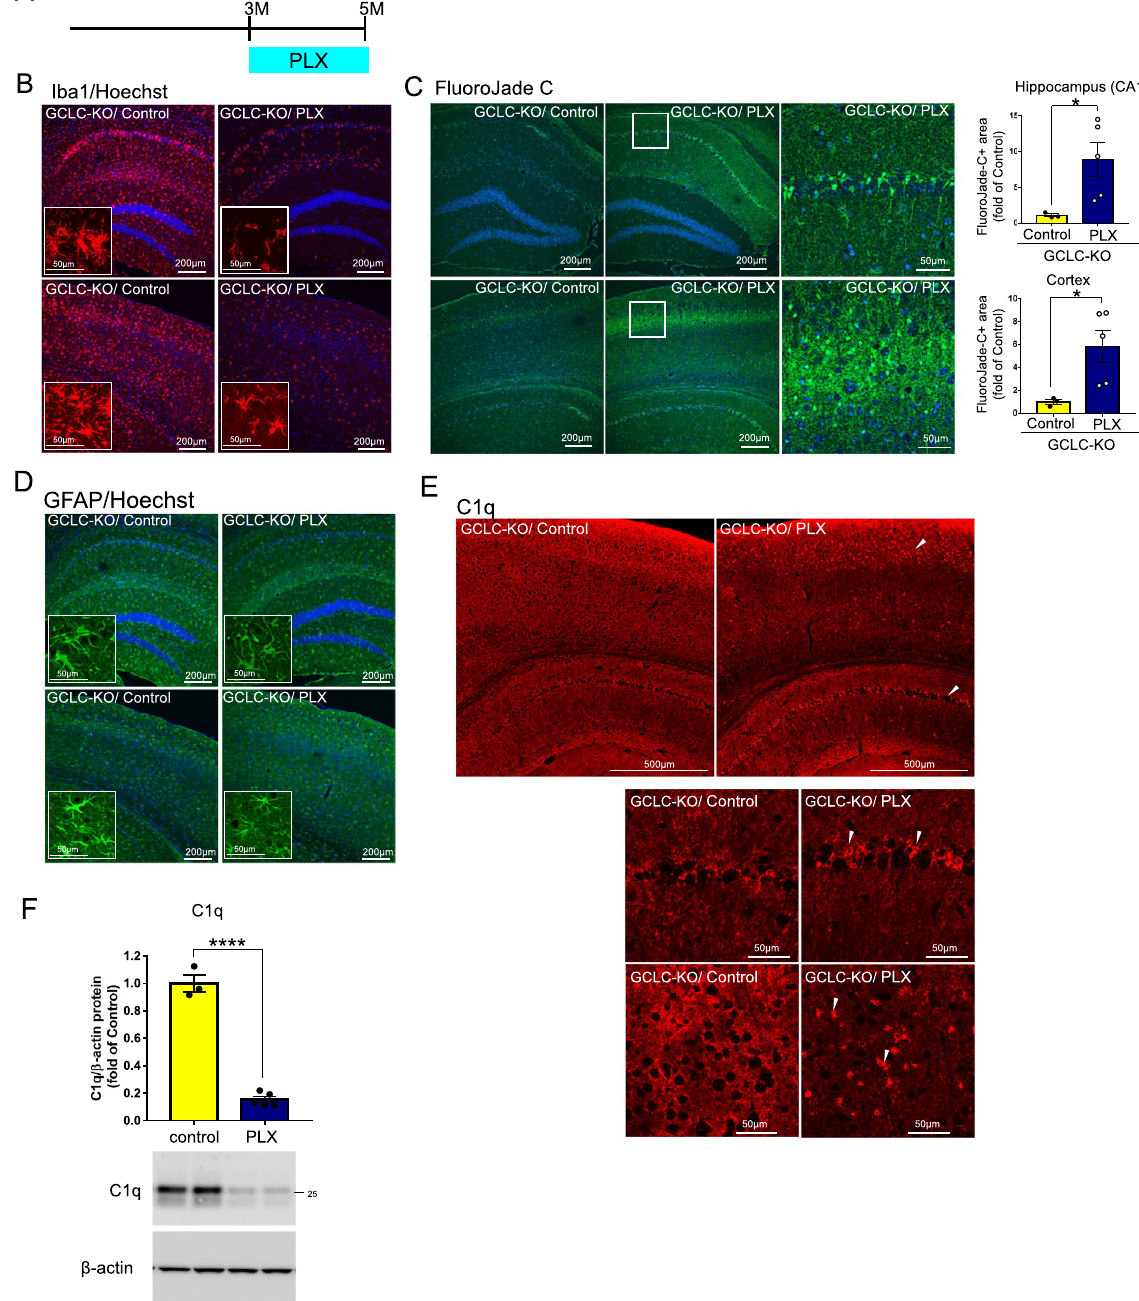
Figure 5. Synaptic pruning by C1q is involved in the reduced volume of GCLC-KO mouse brains. ( A ) Scheme showing PLX3397 (PLX) administration to mice for 2 months. GCLC-KO mice were fed a PLX3397 (PLX)- mixed diet or control diet for 2 months (from 3 to 5 months of age), and brain samples were collected at 5 months of age. ( B–E ) Brain sections from PLX- or control-chow treated GCLC-KO mice were immunostained with Iba1 antibody ( B ), stained with FluoroJade C ( C ), immunostained with GFAP antibody ( D ) or immunostained with C1q antibody ( E ). ( B–D ) Upper panels show the hippocampal CA1 region, and lower panels show the cortical region. ( C ) Magnified images of right panels show the hippocampal CA1 region (upper panels) and layers II–III of the cerebral cortex (lower panels) of PLX treated GCLC-KO mouse. Values shown in the graphs represent the mean intensity level ± SEM (n = 3; ** p < 0.01). ( E ) Magnified images of lower panels show the hippocampal CA1 region (upper panels) and layers II-III of the cerebral cortex (lower panels). ( F ) C1q protein levels in the brains of PLX-treated or control mice were determined by western blotting. Values shown in the graph represent relative expression level of C1q (n = 3 (control) or 5 (PLX); **** p <